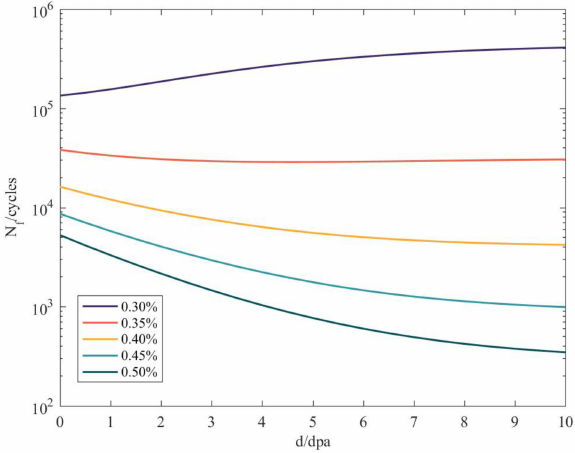
Figure 5. Fatigue life curves for different strain magnitudes.